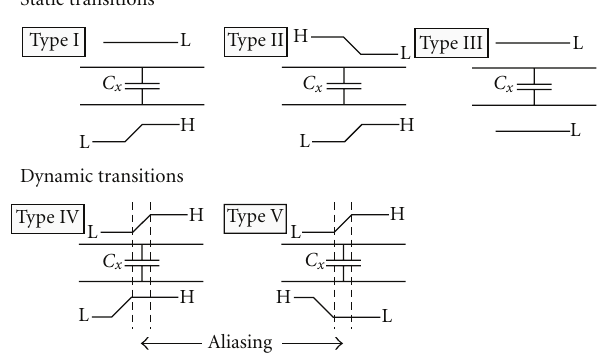
Figure 6: Five transition types for two adjacent